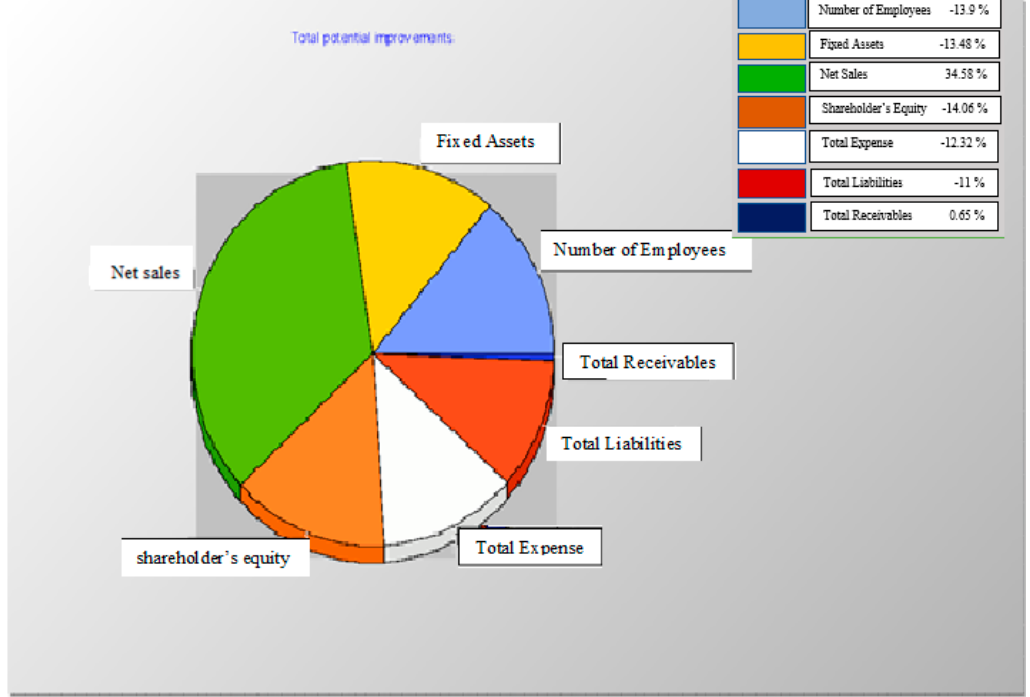
Figure 7. Minimum focused method potential improvement rates with BCC Model. Determination of score rates for CCR model